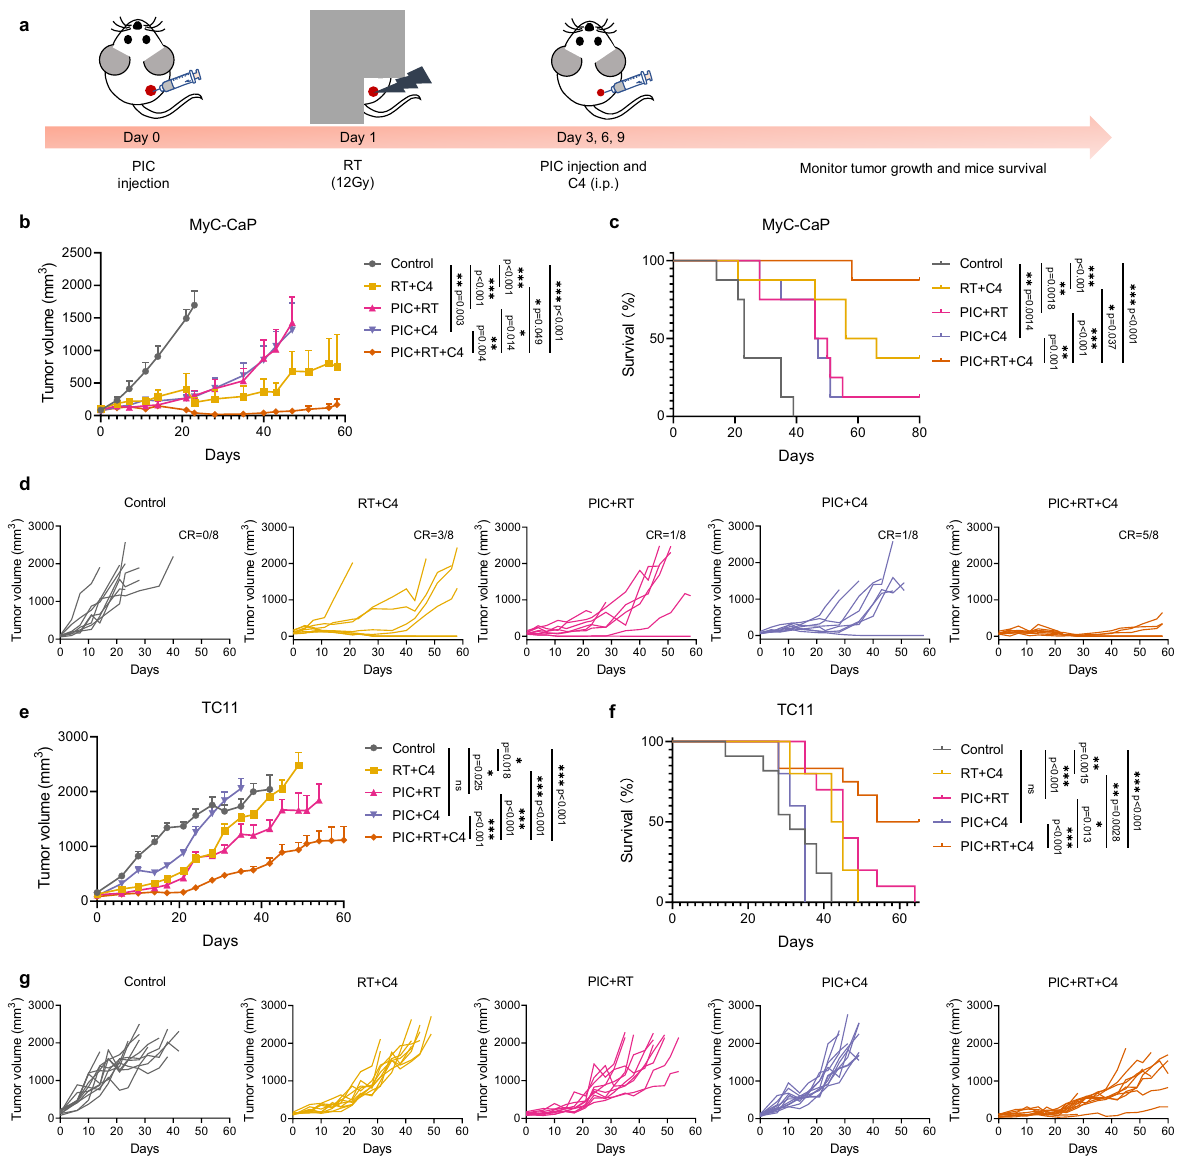
response. C4: anti-CTLA-4. i.p.: intraperitoneal injection. For MyC-CaP prostate cancer model, tumor was implanted on the right fl ank of mice. For TC11 breast cancer model, tumor was implanted on the right mammary fat pad of mice. PIC: 140 μ g/100 μ L/dose. C4: 100 μ g/100 μ L/dose. Data in b and e are shown as mean±SD. Statisticalsigni fi cancewascalculatedvia linear mixedeffects modeling in b and e , and log-rank test in c and f . * p <0.05, ** p <0.01, *** p <0.001 and **** p <0.0001. Source data are provided in Source Data fi